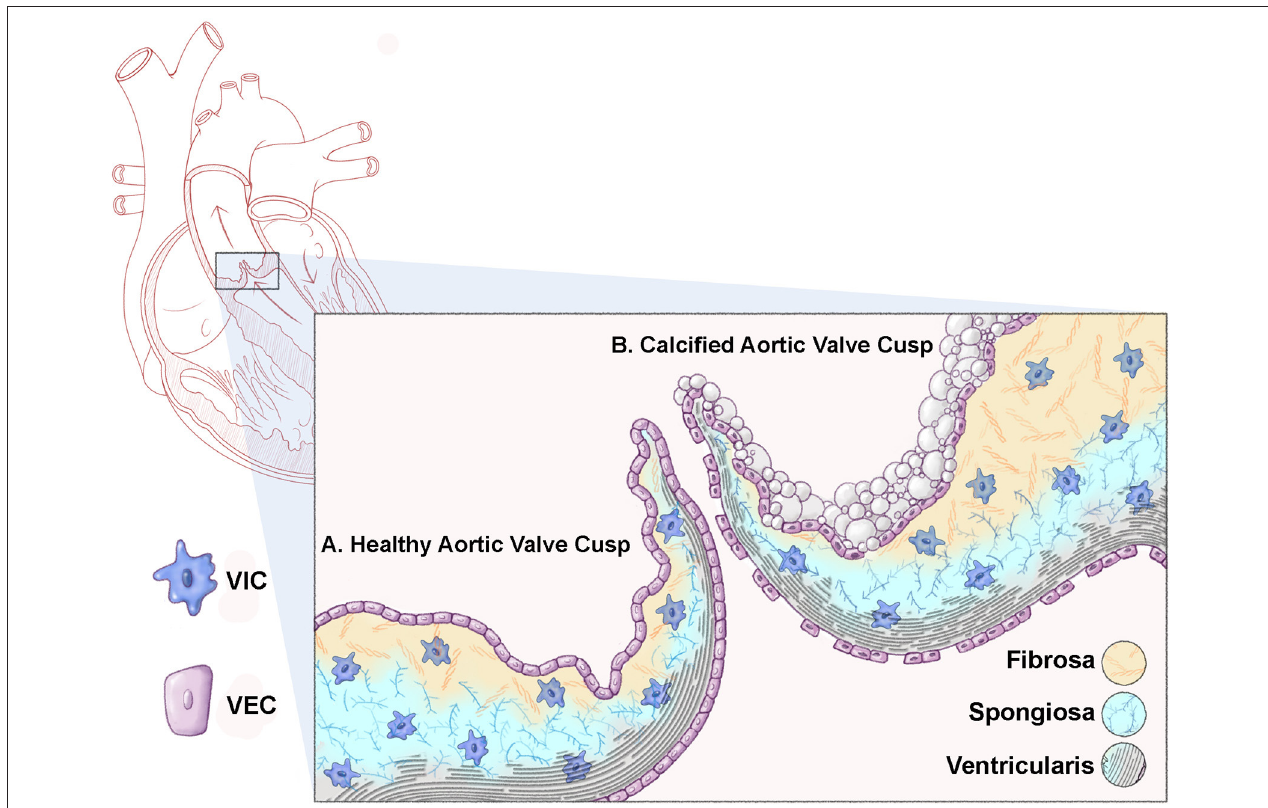
FIGURE 1 | Schematic representation of a healthy and calcified aortic valve cusp. Cross sectional representation of a heart highlighting the aortic valve (box). (A) A healthy aortic valve cusp structure consists of three layers of extracellular matrix (ECM); the ventricularis (elastin fibers, black); the spongiosa (proteoglycans, blue); and the fibrosa (collagens, yellow). In addition to the matrix, the valve cusp is encapsulated by a single layer of valve endothelial cells (VECs), while valve interstitial cells (VICs) populate the core of the cusp. (B) A calcified valve cusp is thickened with abrogations in ECM organization including fragmented elastin fibers and increased collagen content. In addition, calcific nodules form on the fibrosa surface of the cusp (off-white).